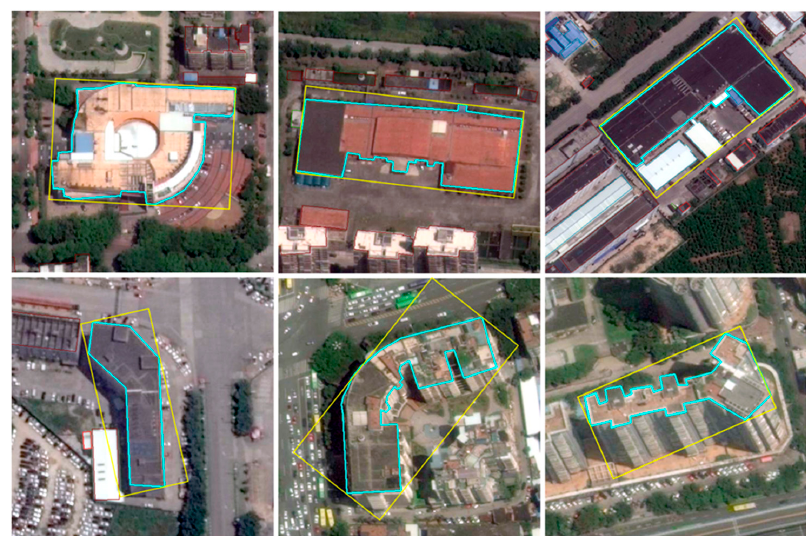
Figure 2. Outline and the minimum area bounding rectangle (MABR) of buildings. Blue lines are the outlines of the buildings and yellow lines are their MABR.